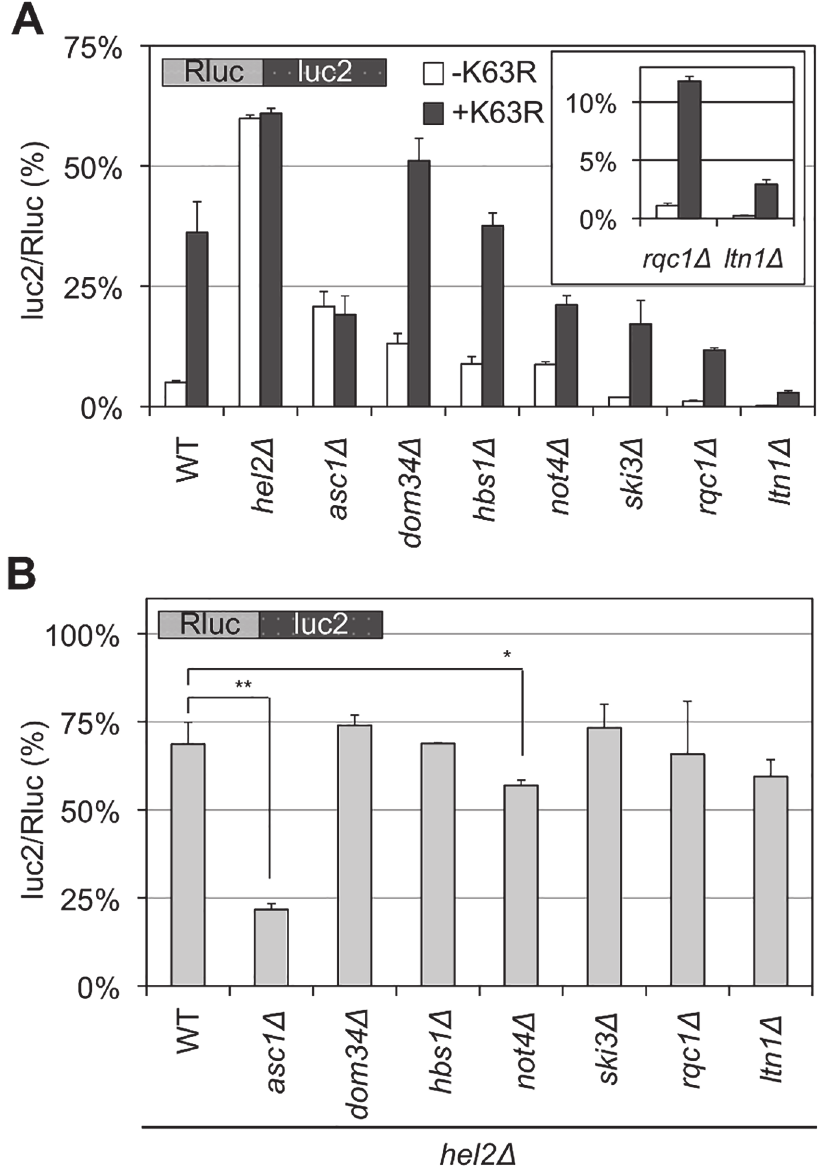
Fig 6. Temporal regulation of K63 polyubiquitination and Hel2 with other factors for stalled translation. (A) The luc2/Rluc ratios for Rluc-luc2 reporter in the wild-type (WT) and single knockout strains (as indicated) in the presence (+K63R) or absence (-K63R) of K63R expression. The inset shows the results for the rqc1 Δ and ltn1 Δ strains. The average luc2/Rluc ratios and their standard deviations were obtained for three independent measurements. (B) The luc2/Rluc ratios for Rluc-luc2 reporter in the strains with double knockout of Hel2 and other factors involved in stalled translation. All strains are hel2 Δ . Thus, as examples, WT in this figure indicates a hel2 Δ single knockout strain, and asc1 Δ indicates the hel2 Δ asc1 Δ strain. The average luc2/Rluc ratios and their standard deviations were obtained for three independent measurements. * p < 0.05, ** p <